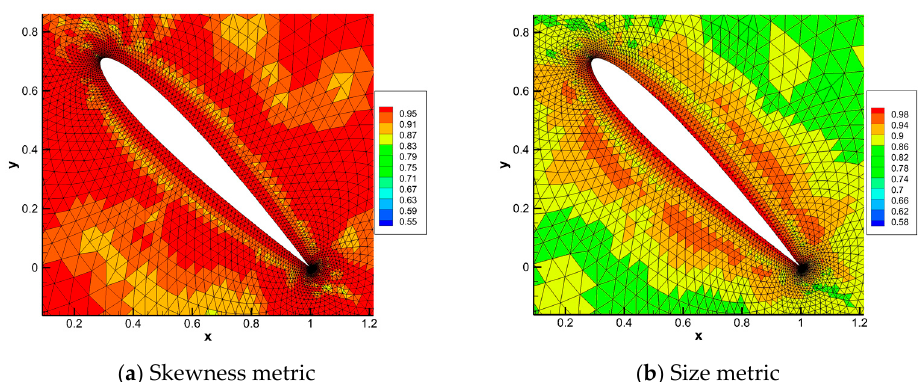
Figure 13. Mesh-based metrics near the airfoil.